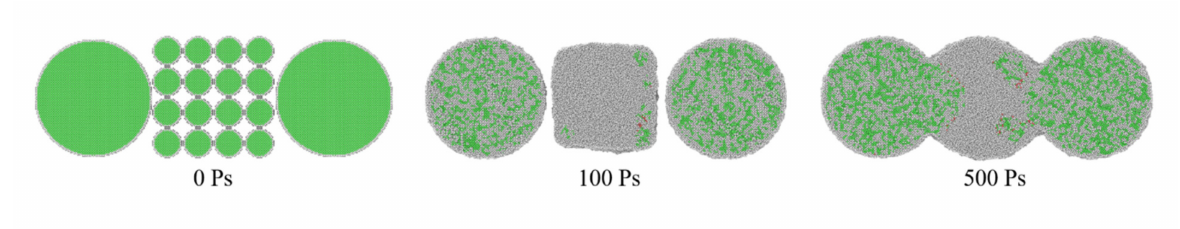
Figure 19. Sintering process of new MPs-520.